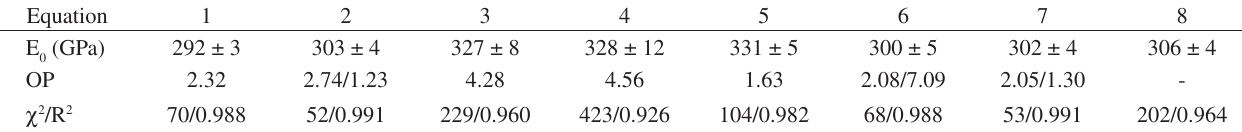
is the Young’s modulus for zero porosity and OP is b for Equations 1, 3, 4, and 5, b 0